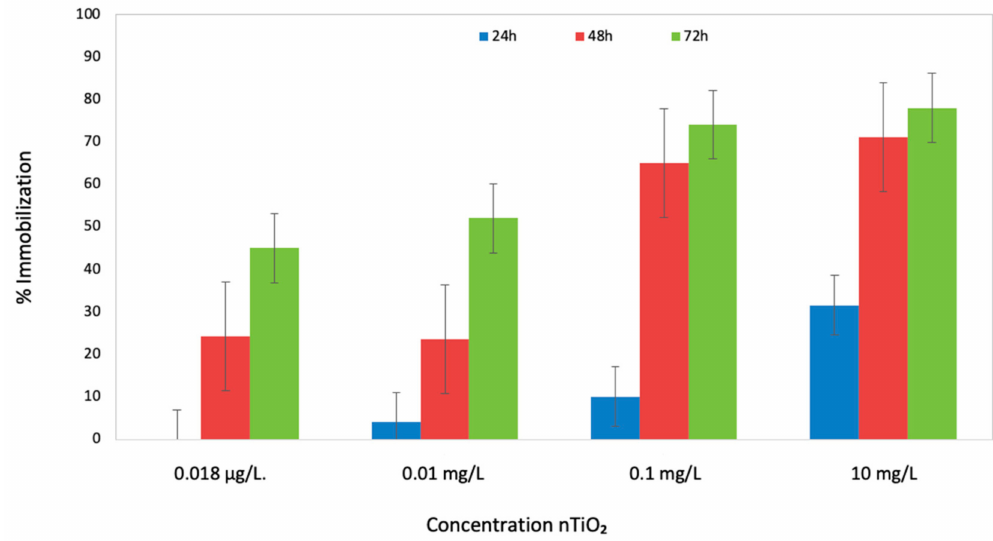
Figure 2. Percentage of immobilization for D. magna exposed to 24 and 48 h to SSR and nTiO 2 . The bars show the span of immobilization of the organism at 0.1, 1, 10, and 100 mg/L nTiO 2